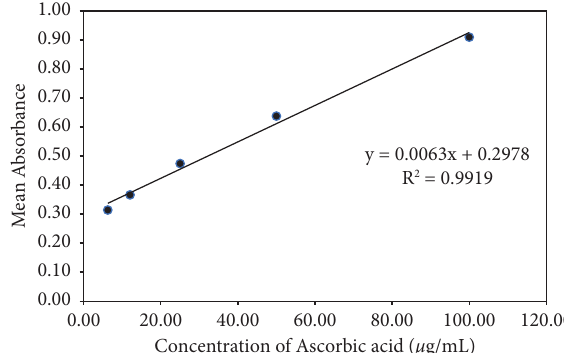
Figure 4: Mean absorbance of PMo V centration of ascorbic acid.